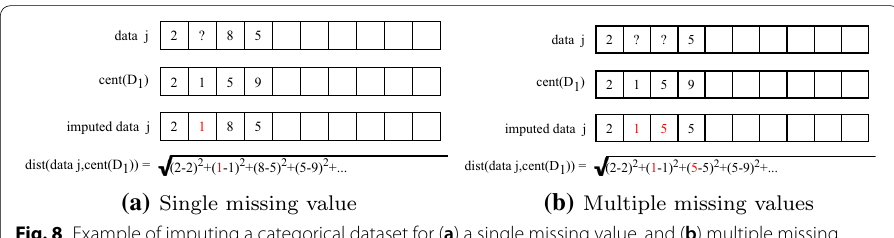
Fig. 8 Example of imputing a categorical dataset for ( a ) a single missing value, and ( b ) multiple missing